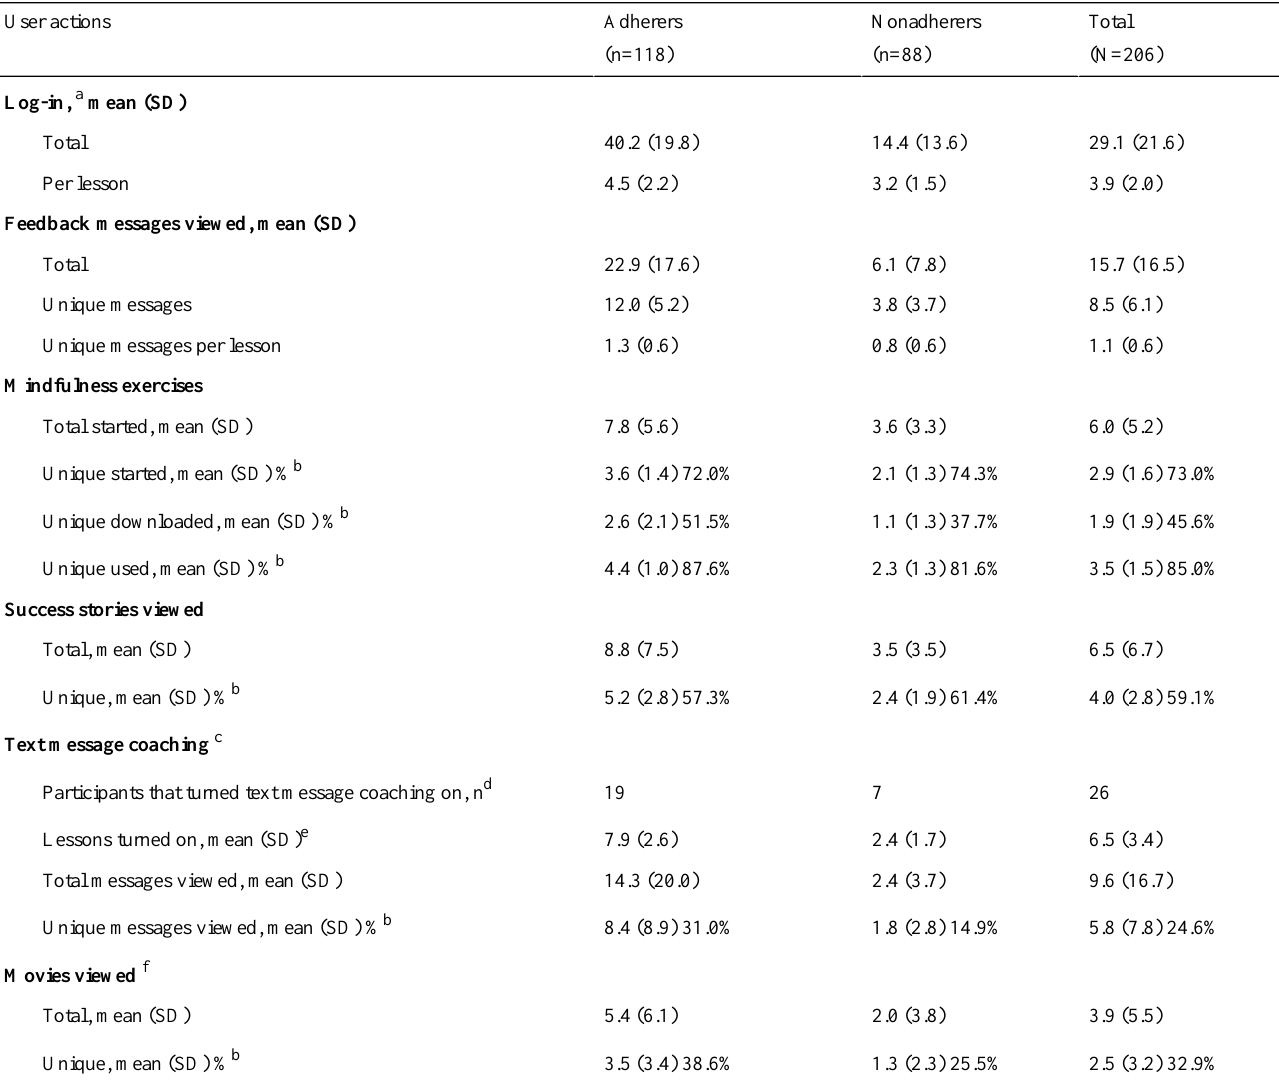
Table 3. User actions of adherers and nonadherers.